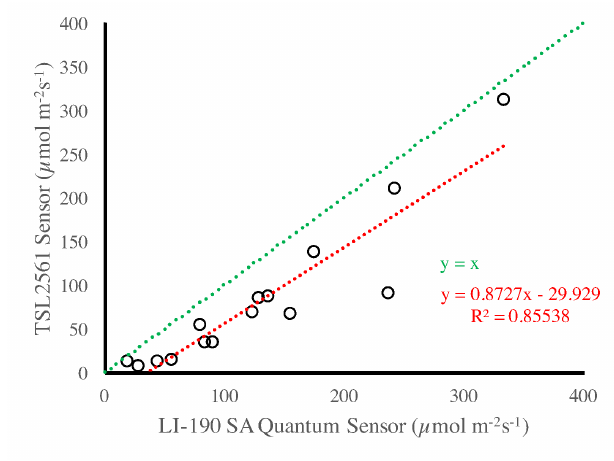
Figure 10. Comparison between data collected with the TSL2561 and the LI-190SA PAR Quantum sensors.